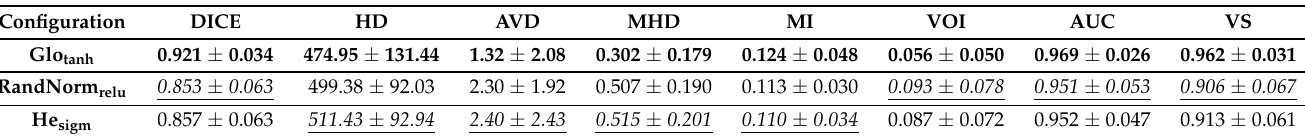
Table 4. Mean and standard deviation values for Segmentation metrics on LiTS Database (higher values represented in bold and lower values in italics with